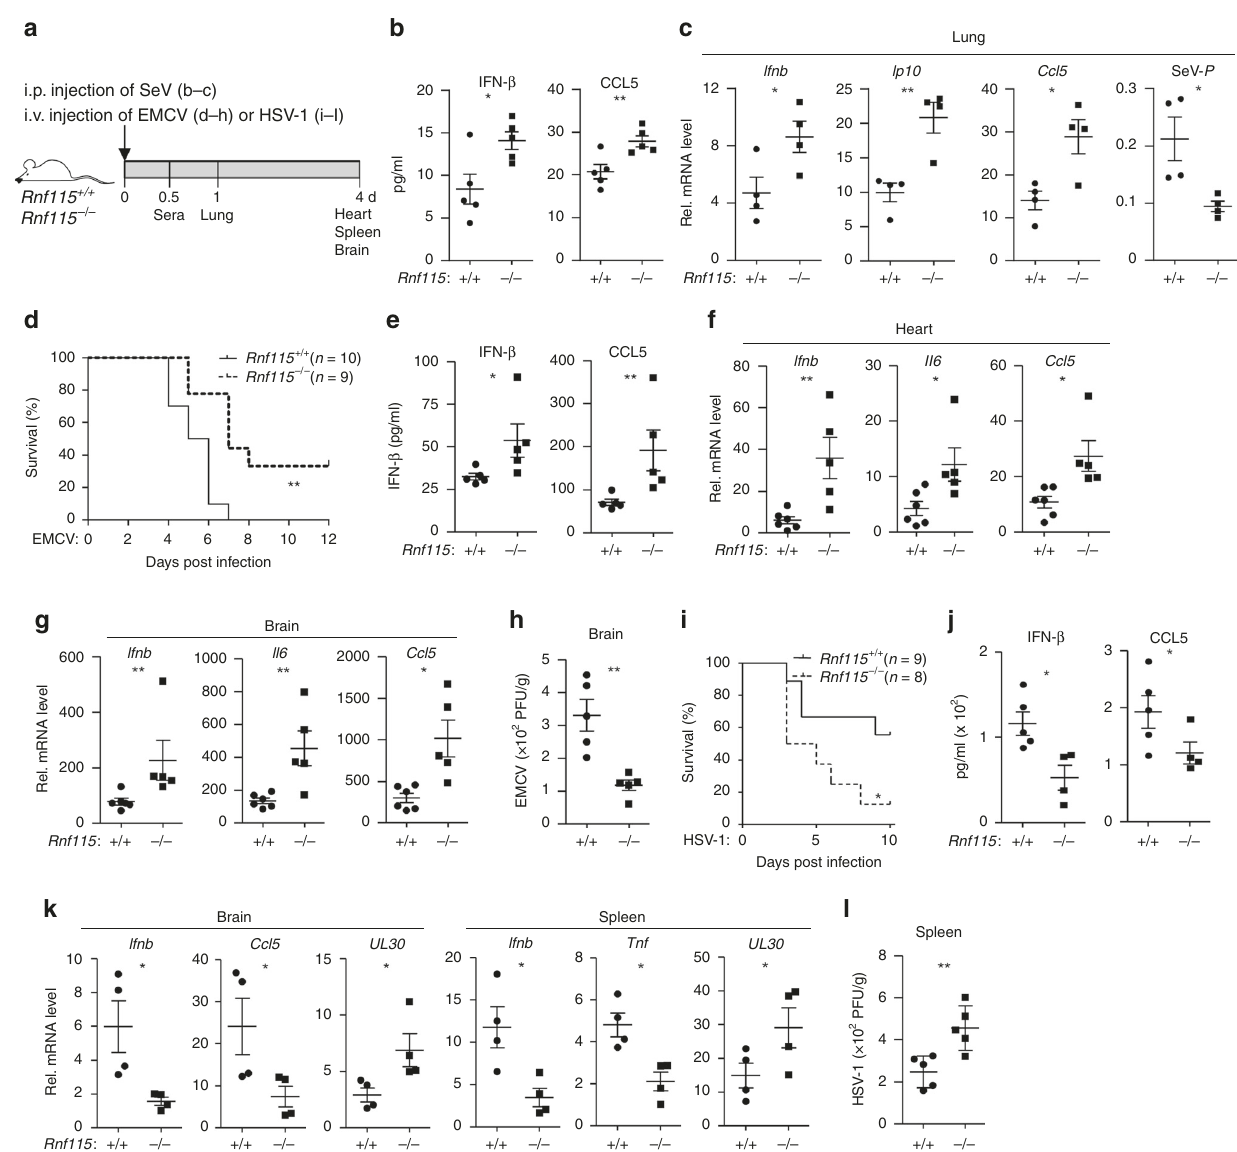
Fig. 4 Rnf115 − / − mice exhibit resistance to EMCV and susceptibility to HSV-1 infection. a A scheme of viral infection and analysis of Rnf115 + / + and Rnf115 − / − mice. b , c ELISA analysis of IFN- β and CCL5 in the sera of ( b ) or qRT-PCR analysis of Ifnb , Ip10 , Ccl5 , and SeV- P mRNA in the lungs from ( c ) Rnf115 + / + ( n = 5) and Rnf115 − / − mice ( n = 5) intraperitoneally injected with SeV for 12 or 24 h, respectively. d Survival (Kaplan – Meier curve) of Rnf115 + / + ( n = 10) and Rnf115 − / − mice ( n = 9) intravenously injected with EMCV (1.8 × 10 6 PFU per mouse) monitored survival for 12 days. e ELISA analysis of IFN- β and CCL5 in the sera of Rnf115 + / + ( n = 6) and Rnf115 − / − mice ( n = 5) intravenously injected with EMCV (1.8 × 10 6 PFU per mouse) for 12 h. f , g qRT-PCR analysis of Ifnb , Il6, and Ccl5 mRNA in the hearts ( f ) and brains ( g ) from Rnf115 + / + ( n = 6) and Rnf115 − / − mice ( n = 5) intravenously injected with EMCV (1.8 × 10 6 PFU per mouse) for 4 days. h Plaque assays analyzing EMCV titers in the brains from Rnf115 + / + and Rnf115 − / − mice intraperitoneally injected with EMCV (2 × 10 6 PFU per mouse) for 4 days. i Survival (Kaplan – Meier curve) of Rnf115 + / + ( n = 9) and Rnf115 − / − mice ( n = 8) intravenously injected with HSV-1 (1 × 10 7 PFU per mouse) and monitored survival for 10 days. j ELISA analysis of IFN- β and CCL5 in the sera of Rnf115 + / + ( n = 5) and Rnf115 − / − mice ( n = 4) intravenously injected with HSV-1 (2 × 10 7 PFU per mouse) for 12 h. k qRT-PCR analysis of Ifnb , Ccl5 , Tnf , and UL30 mRNA in the brains and spleens from Rnf115 + / + ( n = 4) and Rnf115 − / − mice ( n = 4) intravenously injected with HSV-1 (2 × 10 7 PFU per mouse) for 4 days. l Plaque assays analyzing HSV-1 titers in the spleens from Rnf115 + / + and Rnf115 − / − mice intraperitoneally injected with HSV-1 (2 × 10 7 PFU per mouse) for 4 days. * P < 0.05, ** P < 0.01 (two-tailed Student ’ s t -test or log-rank analysis). Data are of combined three independent experiments ( a , f ) or representative of two independent experiments ( b – e , g – i ) (graphs show mean ± SD in b – e , g – i ). Source data are provided as a Source Data fi